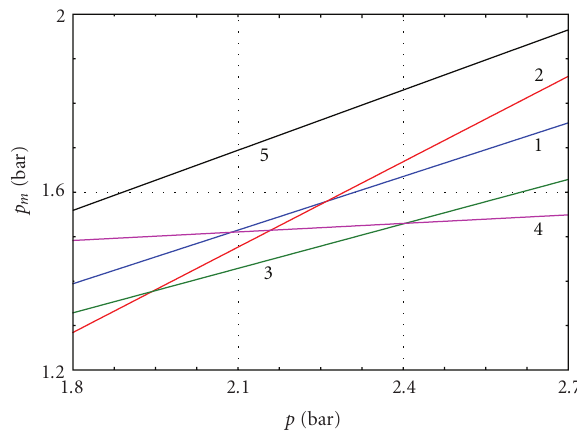
Figure 7: Mean values of contact areas (for total range of normal load) as a function of pressure.